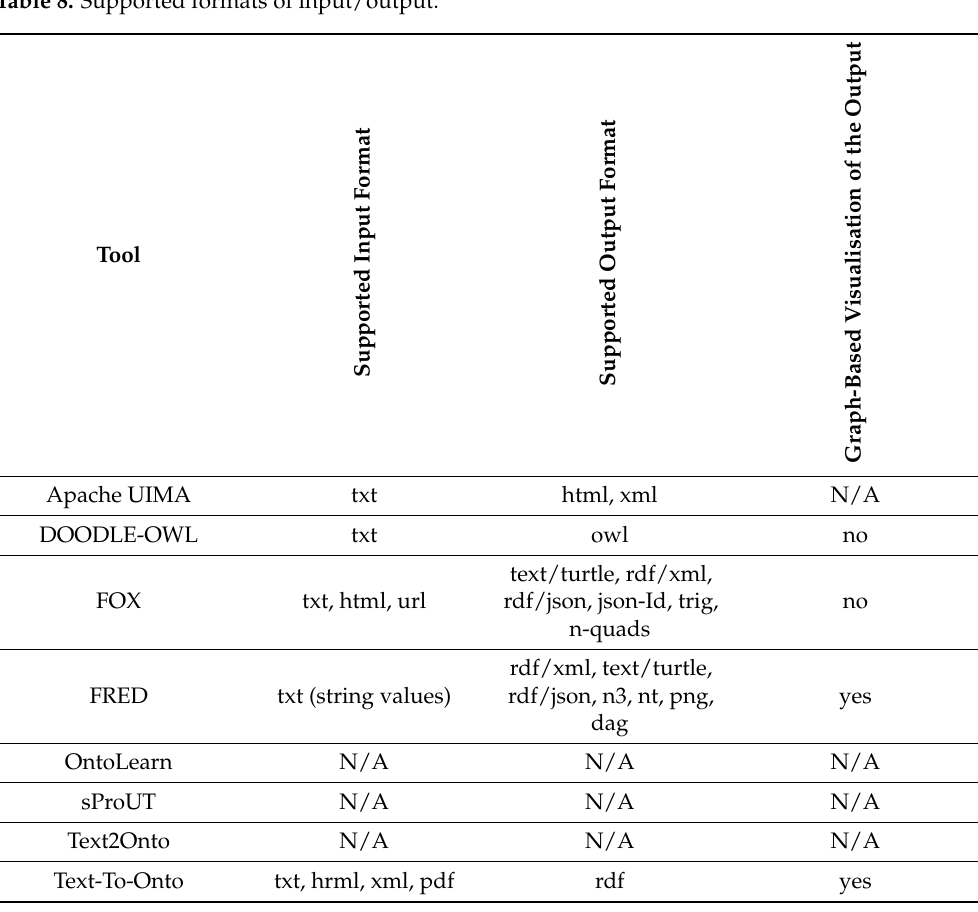
Table 8. Supported formats of